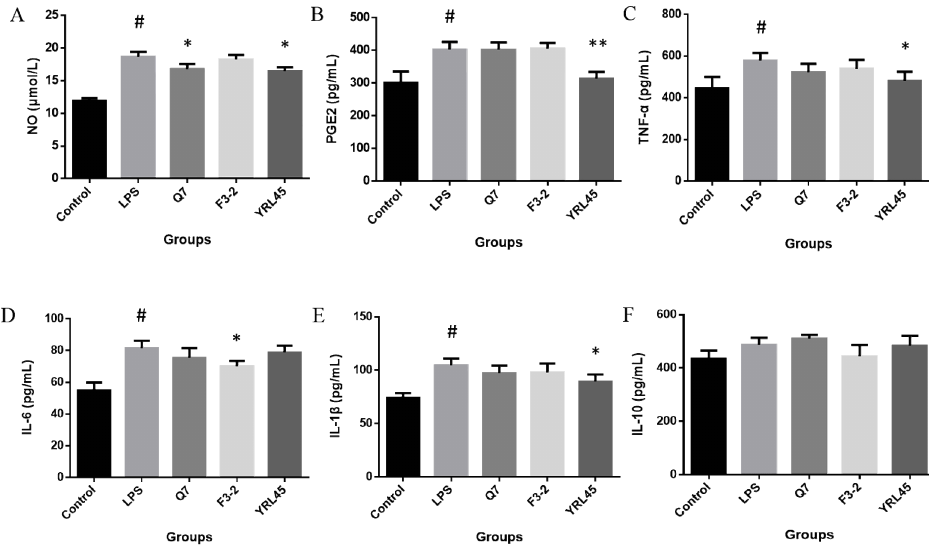
Figure 5. Effect of L. plantarum Q7, L. plantarum F3-2 and L. plantarum YRL45 on the secretion of NO ( A ), PGE2 ( B ), TNF- α ( C ), IL-6 ( D ), IL-1 β ( E ) and IL-10 ( F ) in Raw264.7 cells. # p < 0.05: LPS group compared with control group. * p < 0.05: strain groups compared with LPS group. ** p < 0.01: strain groups compared with LPS group.